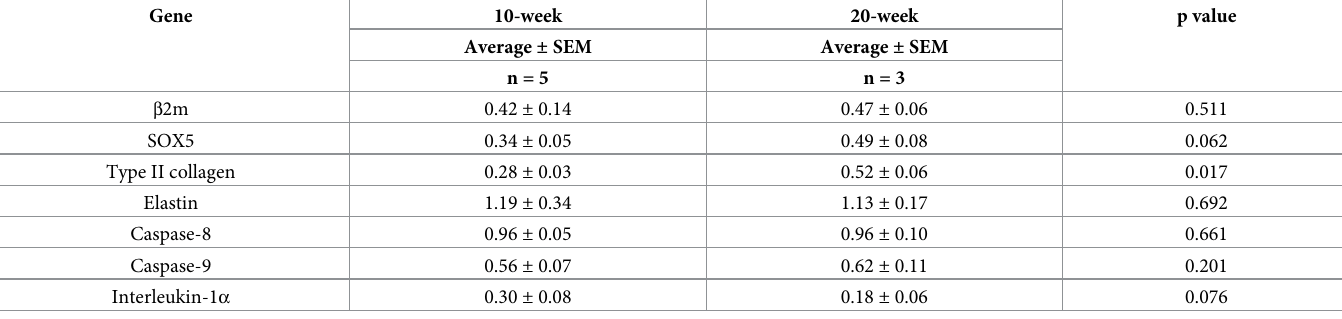
Table 2. Average gene expression values normalized to P0 for human auricular chondrocytes seeded onto ethanol-treated scaffolds and retrieved from tissue-engi- neered constructs after 10- or 20-weeks of implantation in nude